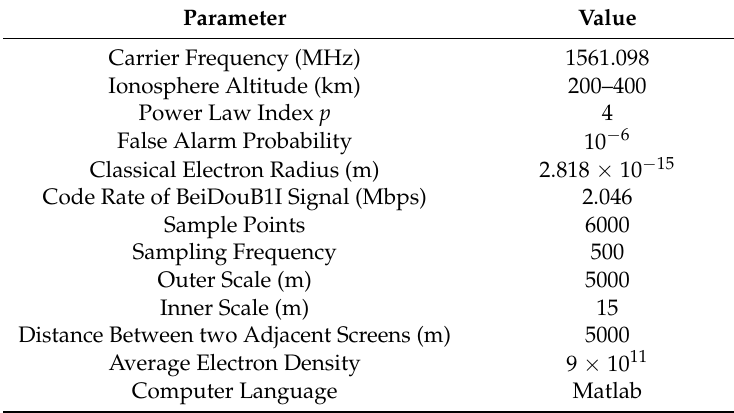
Table 1. Simulation